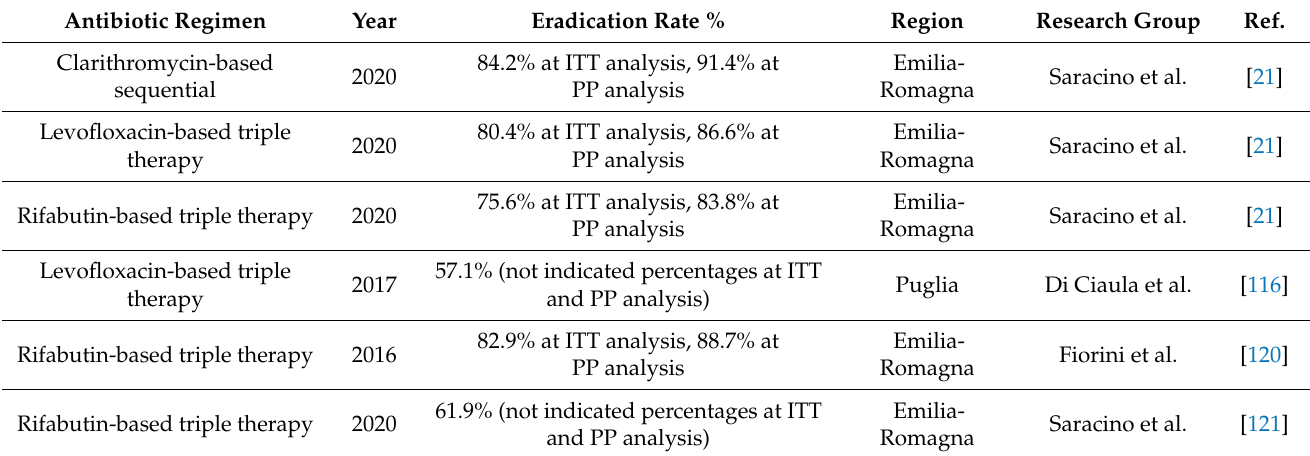
Table 12. Eradication Rate of other regimens in treatment experienced